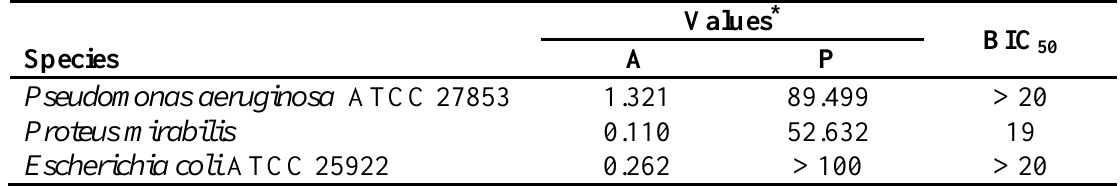
Table 2. Anti-biofilm activity of ethanolic extract from Zingiber